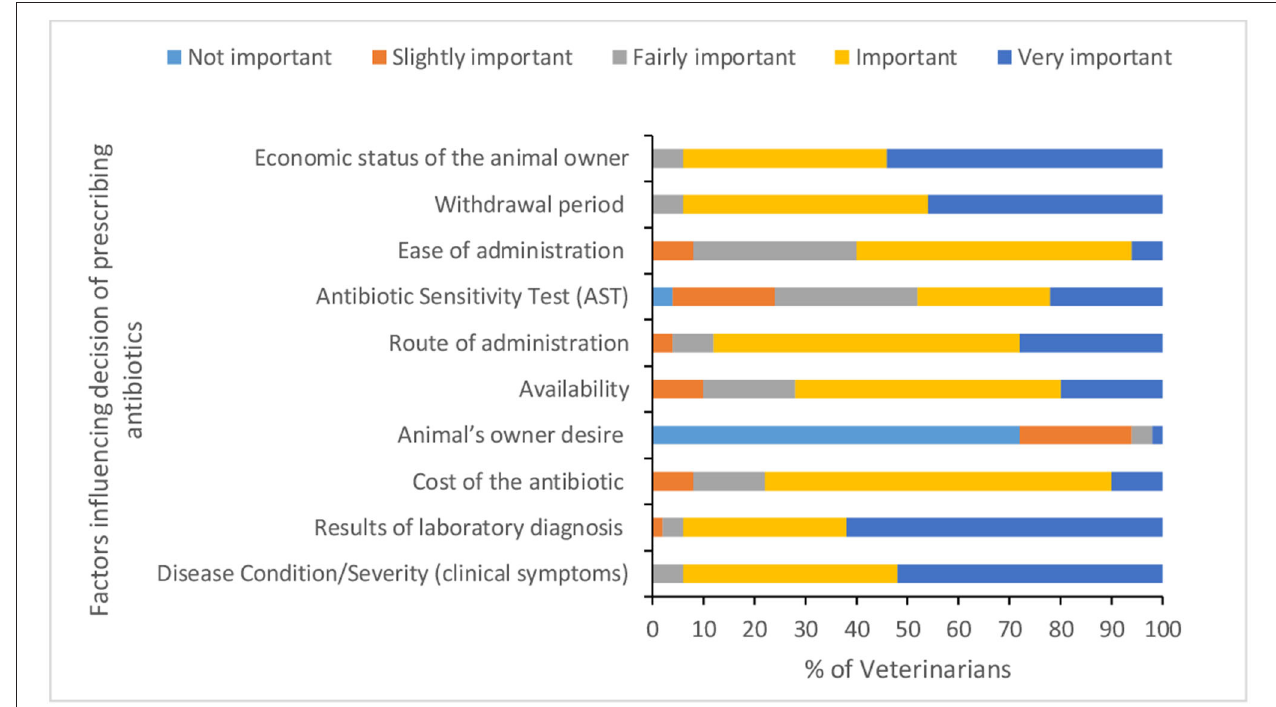
FIGURE 3 | Factors influencing the selection of antibiotics by the